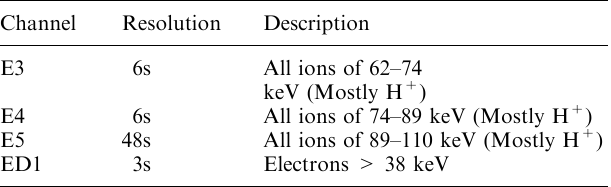
Table 1. EPIC/ICS